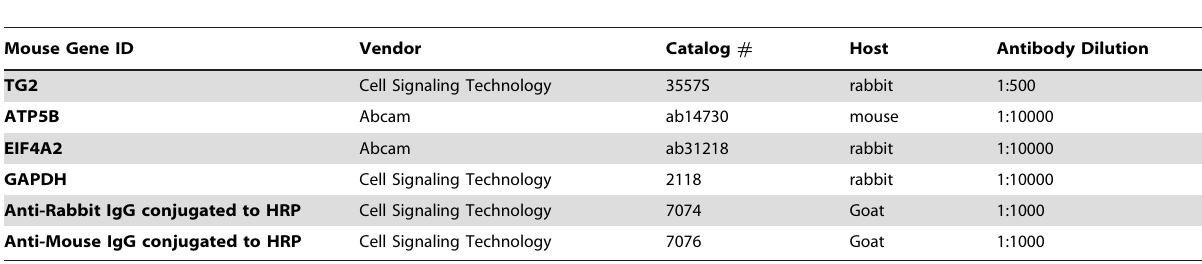
Table 4. Quantitative Western Blots Antibody